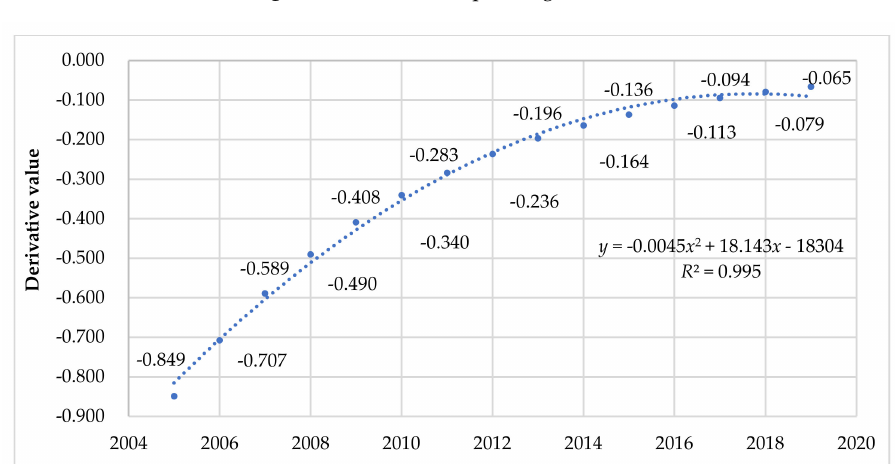
Figure 4. Cost of CPV power generation.